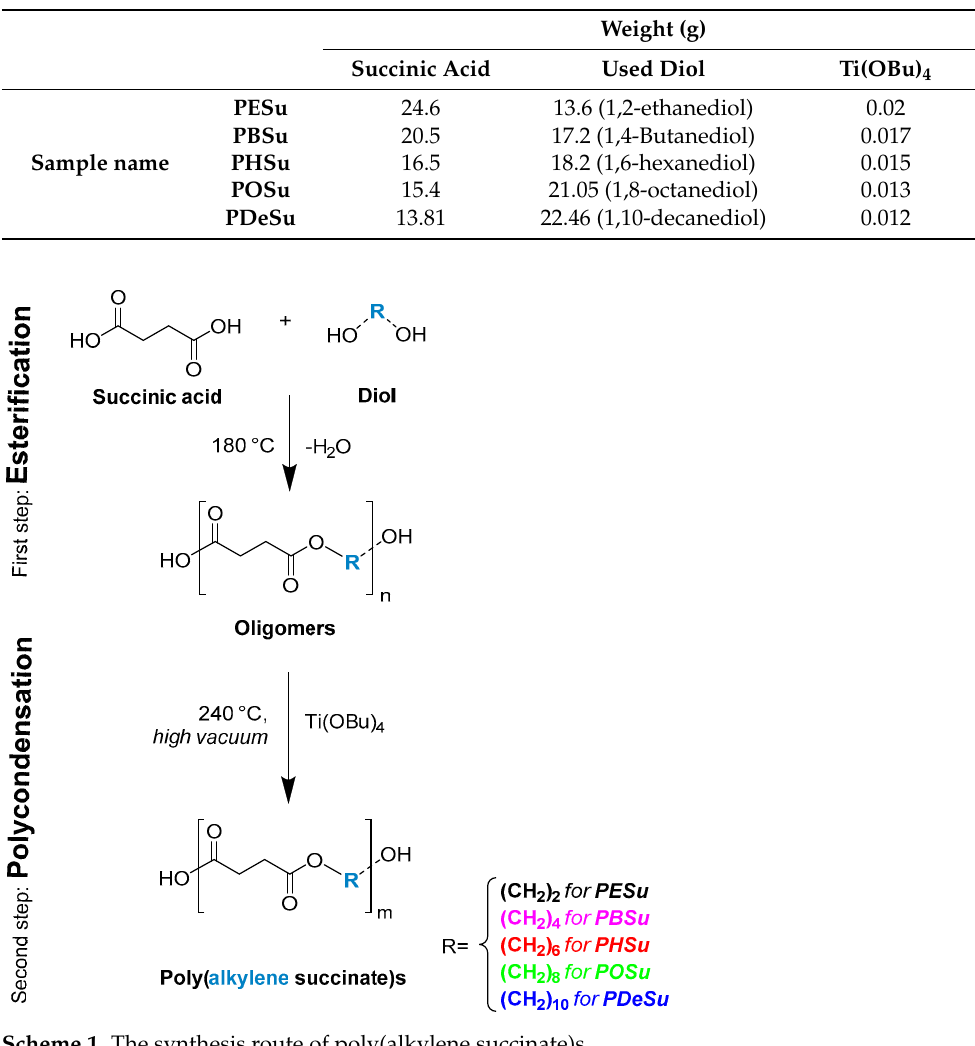
Table 1. Weighting values for the diol, succinic acid, and catalyst used for the synthesis of poly(alkylene